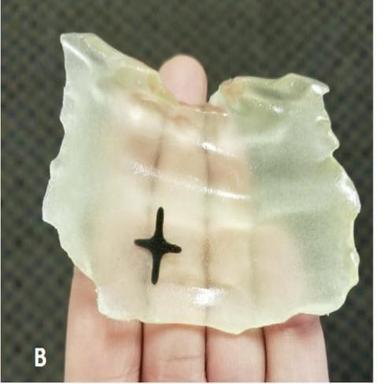
Examples of 3D bolus used to treat a skin malignancy involving the nose (A) and lip (B) are shown. The black cross provides built-in daily setup localization at the treatment isocenter for use with an in-room laser alignment system. This mark has been printed into the bolus and aids in rapid, reproducible bolus placement. Panel B demonstrates the excellent bolus clarity.